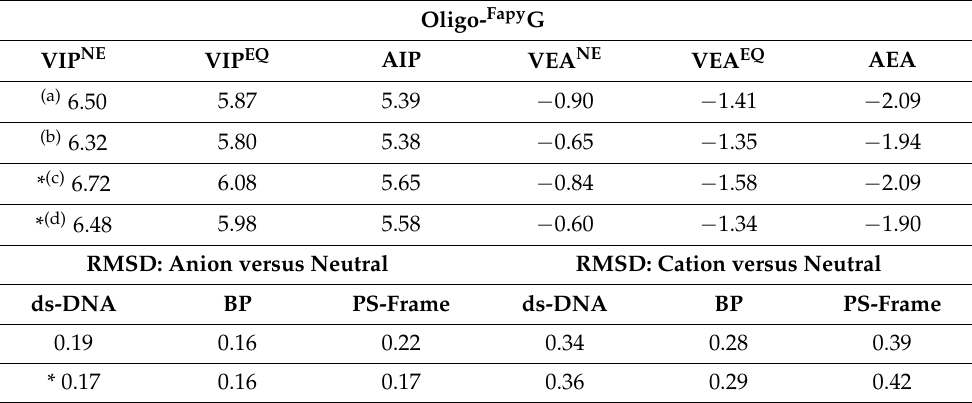
Table 2. Electronic properties, in [eV], of oligo- Fapy G: Vertical (VIP), adiabatic ionization potential (AIP) and vertical (VEA), adiabatic (AEA) electron affinity calculated at the M062x/6-31++G** level of theory in the aqueous phase. (a,c) complete double helix and (b,d) base-pair skeleton, NE—non- equilibrated solvent-solute interaction, EQ—equilibrated solvent–solute interaction, * data calculated for corresponding native ds-oligo [30]. Root-Mean-Square Deviation (RMSD) of atomic positions in [Å 2 ], calculated for neutral, anionic and cationic forms of oligo- Fapy G. The row data have been given in Table S1 of Supplementary Materials. Oligo- Fapy G